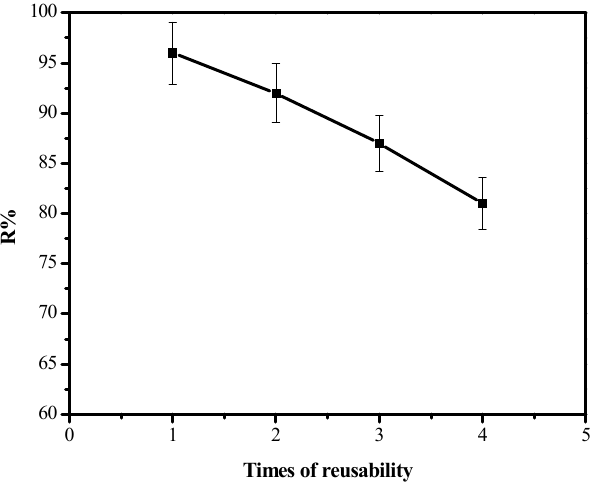
Figure 14. Reusability of the GA/MNPs for the removal of Pb(II) ions.